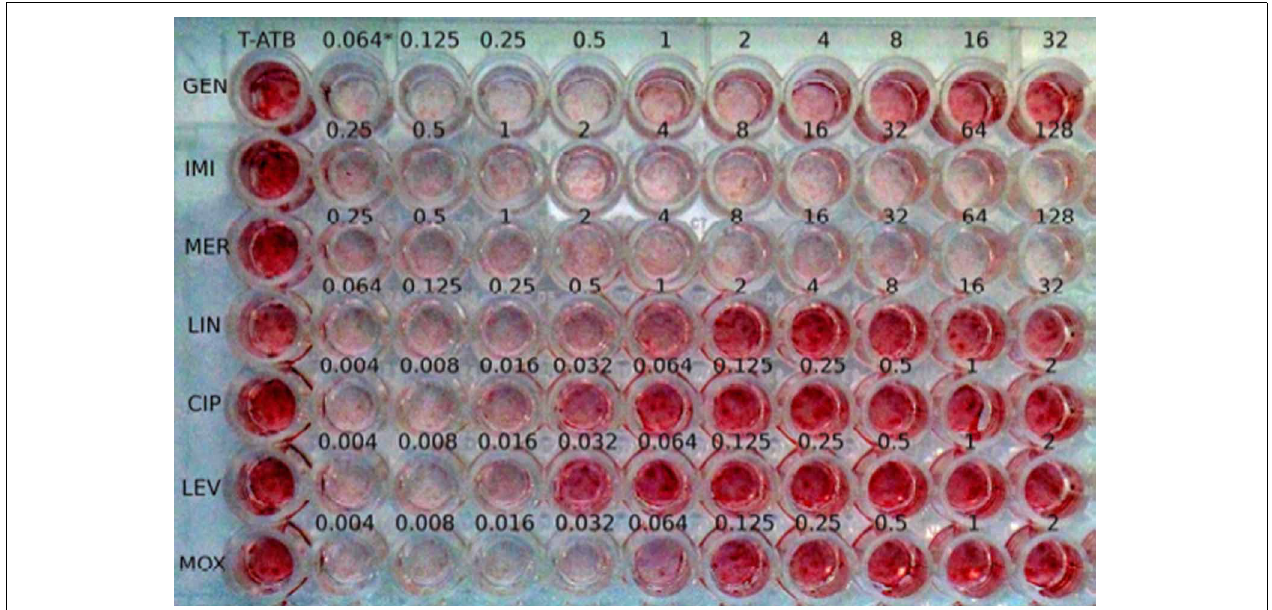
antibiotic tested; GEN, gentamicin; IMI, imipenem; MER, meropenem; LIN, linezolid; CIP, ciprofloxacin; LEV, levofloxacin; MOX,